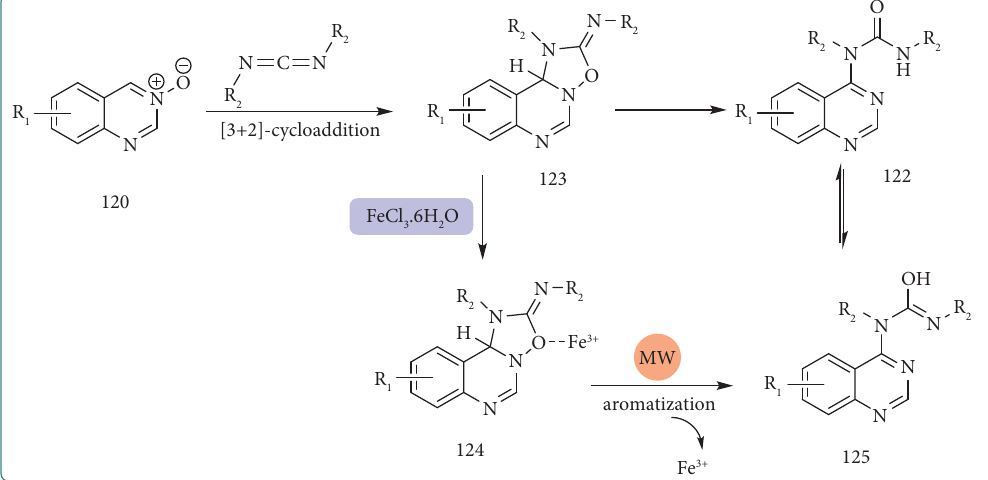
3 .6H 2 O, under microwave irradiation